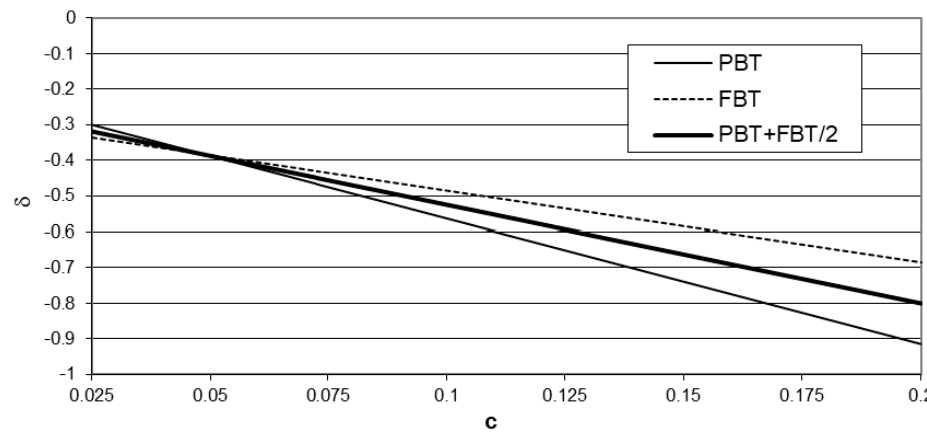
Figure 14. Dependence of κ on c for both agitators.